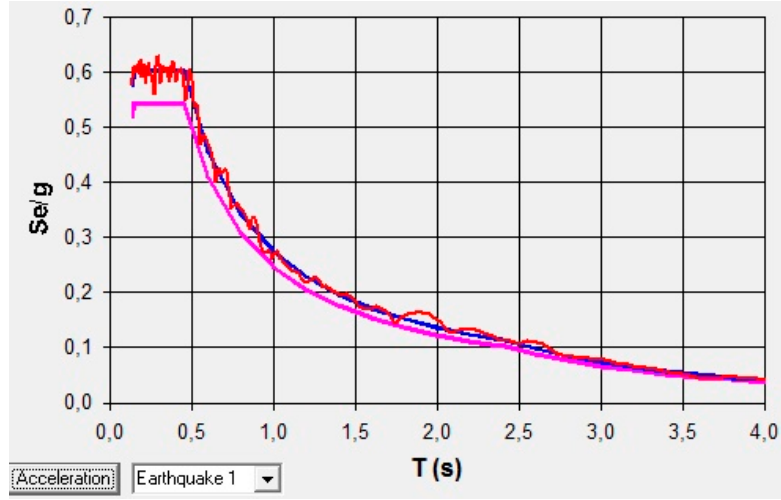
Figure 2. Compatibility verification of one of the accelerograms used.